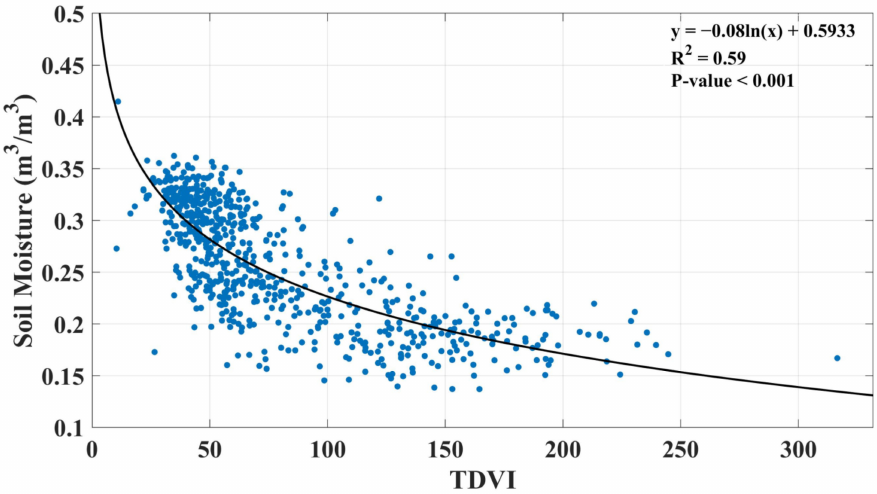
Figure 3. Logarithmic relationship between site-averaged SM and pixel-averaged